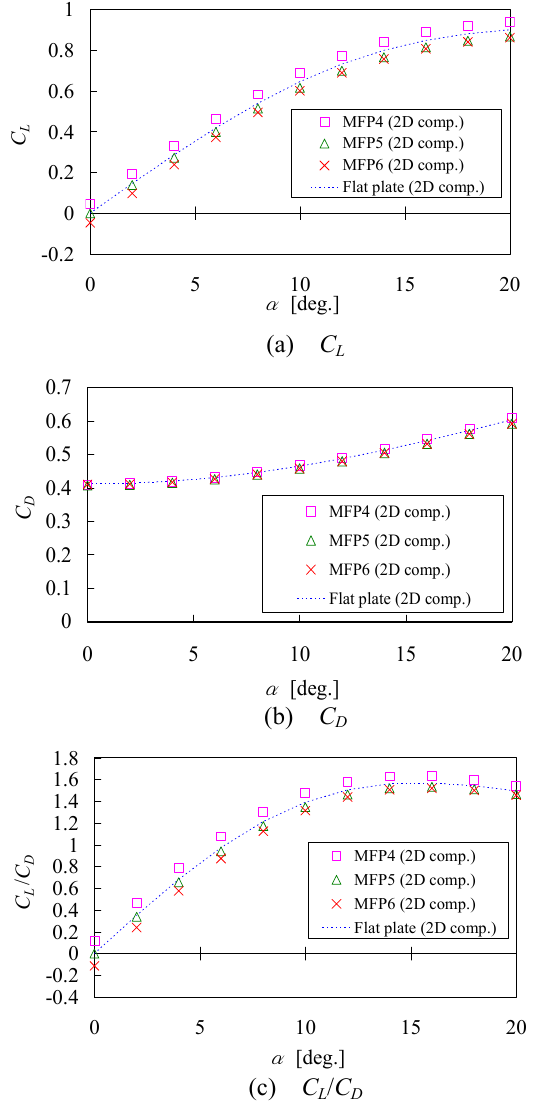
Fig. 13 Aerodynamics characteristics versus α at Re =1.0×10 2 (MFP4, MFP5 and